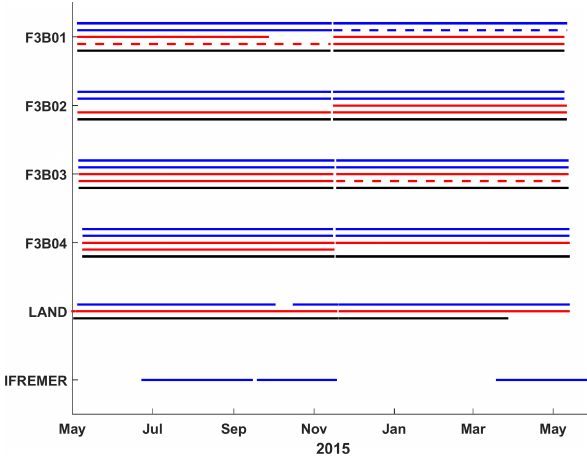
Figure 3. Data return, legs 1 and 2. For the moorings F3B01- 04, ADCPs are in blue, CTD sensors are in red and UBTIs are in black. The top lines correspond to the shallowest unit. For the land- based stations (LAND), DOGIS SUTRON weather station are in blue, DOGIS U30 weather station is in red and POOLC SUTRON tide gauge is in black. IFREMER ADCP data (SPMGF) is in blue. Dashed lines represent partial data recovery (e.g. ADCP tilted, CTD having no or partial salinity return).